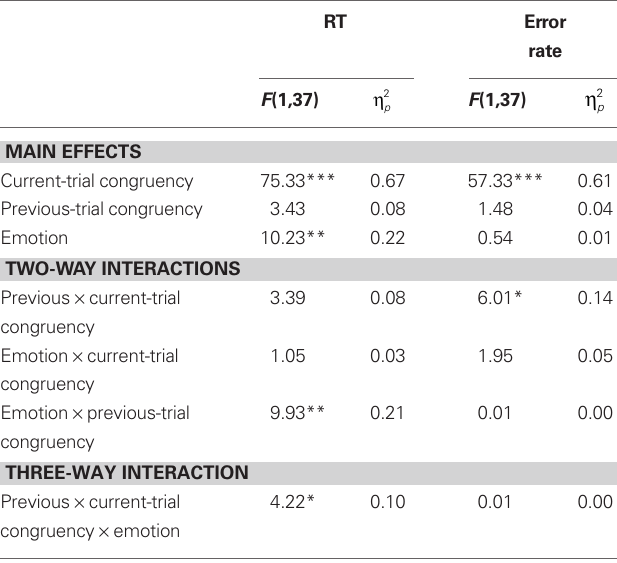
Table 2 | Statistical results from repeated-measures aNova analysis on the behavioral